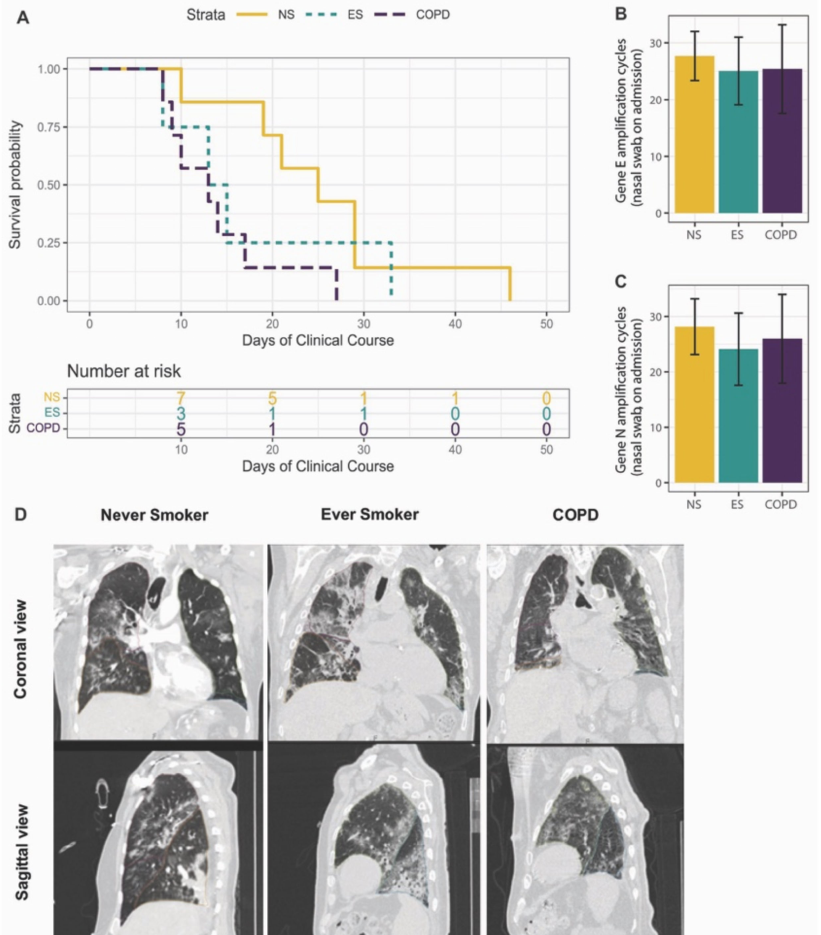
Figure 1. COVID-19 patient characteristics: ( A ) Survival curve for the days of the clinical course of never-smokers (NS), ever-smokers (ES), and COPD patients infected with severe acute respiratory syndrome coronavirus 2 (SARS-CoV-2). The survival analysis was performed using day one of COVID-19 symptoms and day of death in hospital, using a log-rank test. ( B,C ) The gene expression levels of the envelope (E) ( B ) and nucleocapsid (N) ( C ) SARS-CoV-2 genes were quantified in nasal swabs. ( D ) Thoracic computed tomography (CT) coronal and sagittal views in a representative never smoker (left panel), ever-smoker (middle panel), and patient with COPD (right panel) within four days before death due to SARS-CoV-2